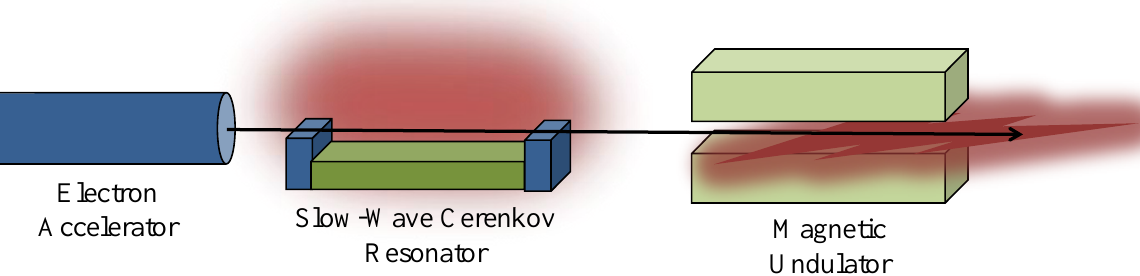
Figure 1. Schematic drawing of the hybrid FEL under study. The accelerated electron beam generates radiation interacting with the Cerenkov resonator. The electric beam associated with the stored radiation modulates the electrons’ velocities in order to obtain the most efficient emission in the magnetic undulator radiator.